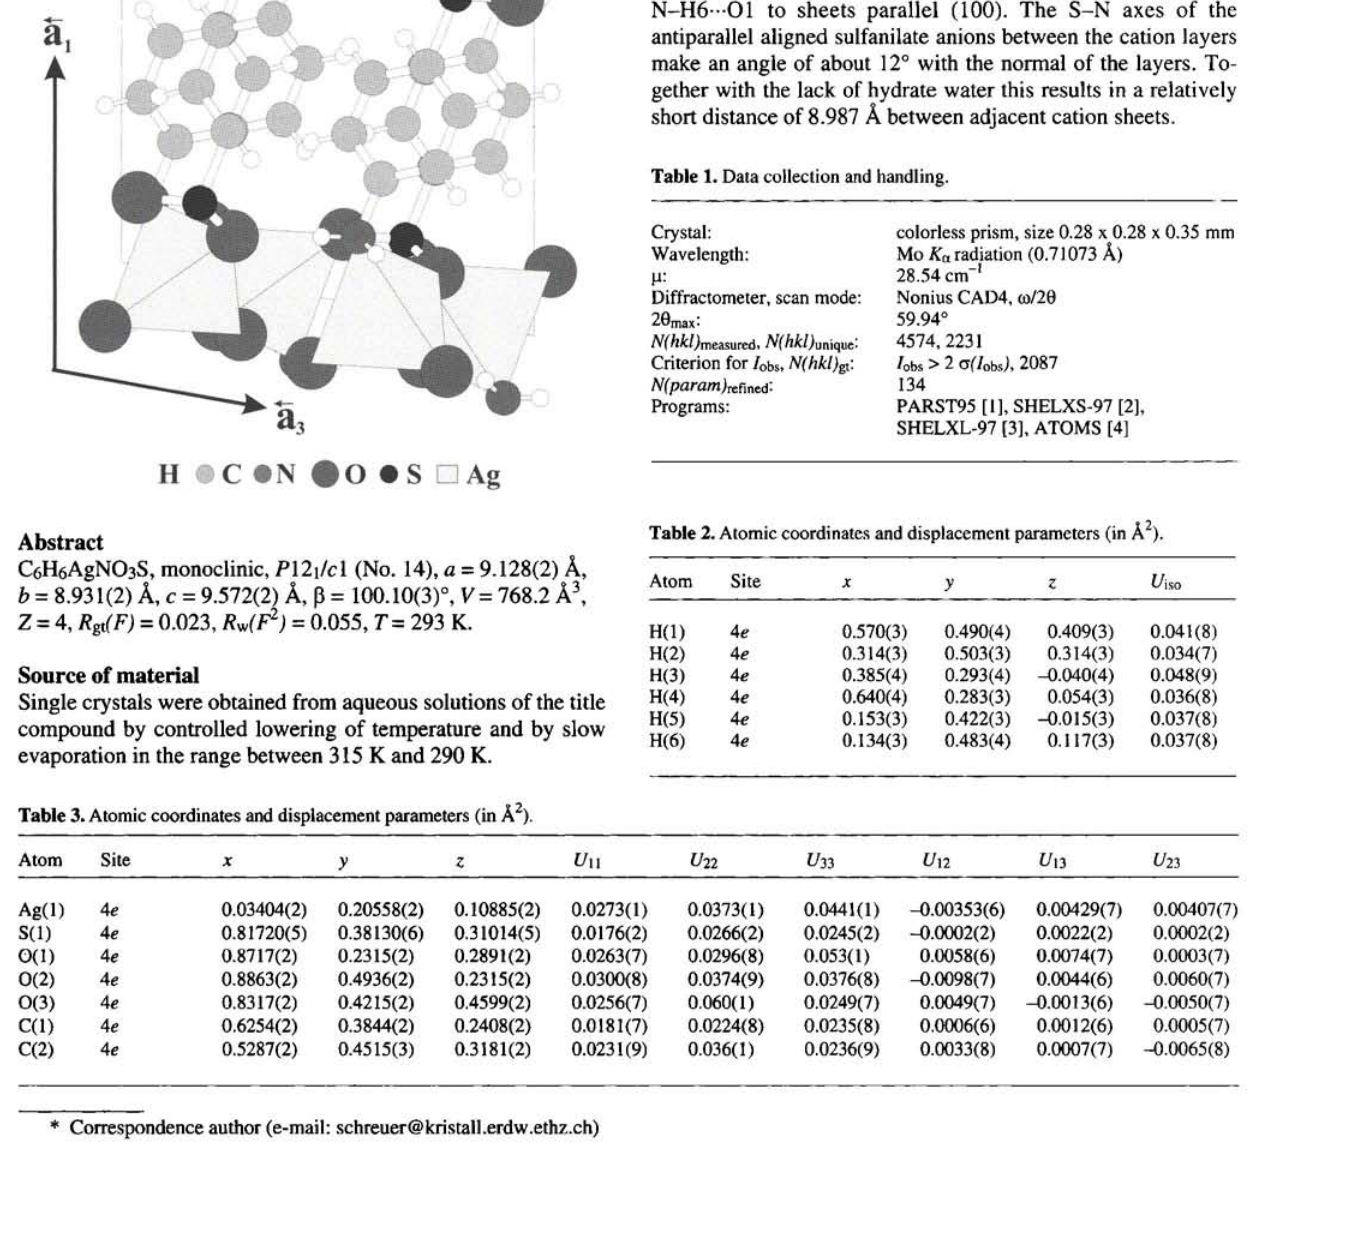
Table 2. Atomic coordinates and displacement parameters (in À 2